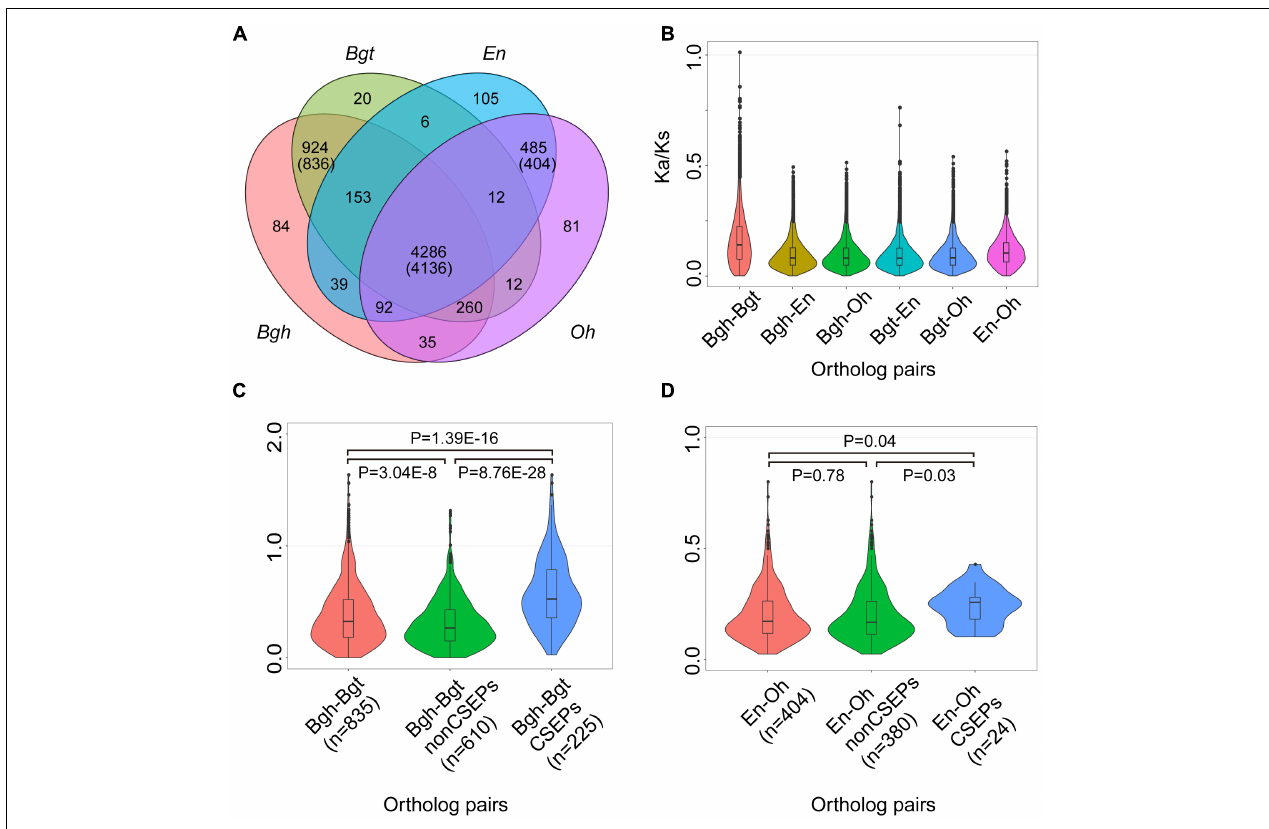
FIGURE 3 | CSEP K a/ K s ratios are higher than conserved and lineage-specific orthologous genes. (A) Comparison of orthologous genes among powdery mildews. Numbers in parentheses indicate shared families corresponding to single-copy orthologs. (B) Pairwise K a/ K s show purifying selection in 4,136 single-copy ortholog families shared by four powdery mildews. Each family has six combinations ( n = 4,136 for each combination). (C) Pairwise K a/ K s for the 836 single-copy gene families shared by two monocot powdery mildews. After filtering for K s > 0 ( n = 835) for monocot powdery mildews. (D) Pairwise K a/ K s for 404 single-copy gene families shared by two dicot powdery mildews. Statistical analyses were conducted using Student’s t -test between two